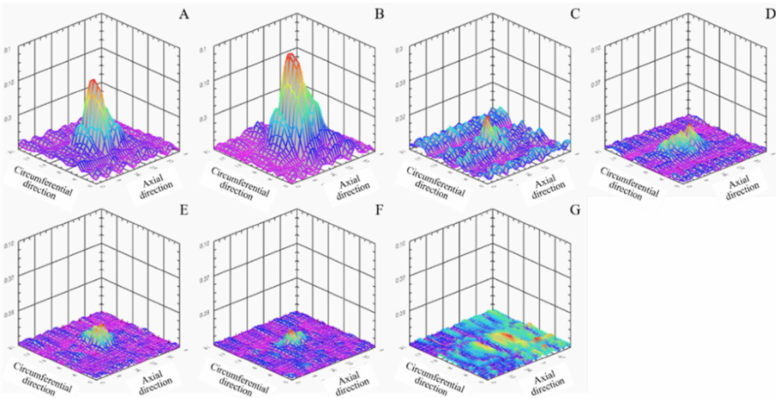
Figure 9. 3D image of the T-EMF from the BIGiS for the specimen with di ff erent type flaws (30 kHz